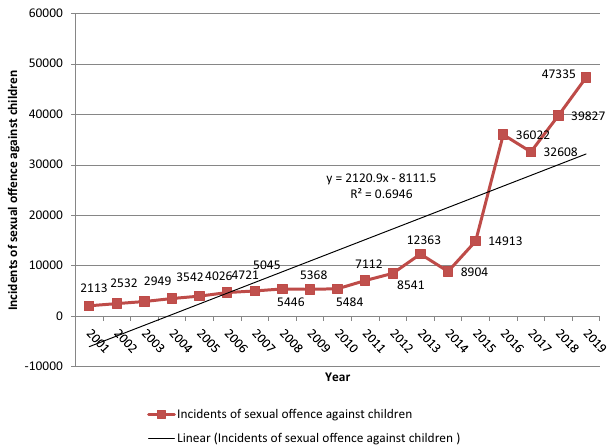
Fig. 1 Incidents of sexual offence against children in India overtime. Authors ’ own presentation based on NCRB data.